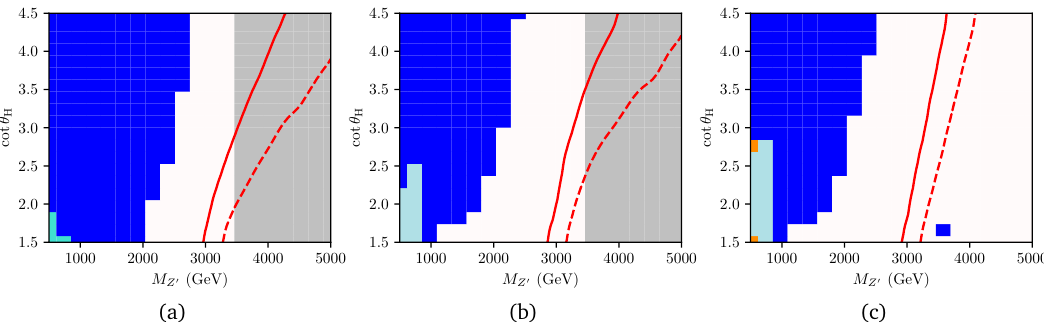
Figure 4: Exclusions derived using Herwig . (a) As Fig. 1b but only using those mea- surements for which SM predictions are available. (b) Expected limit. (c) Measured limits using the SM predictions as background.